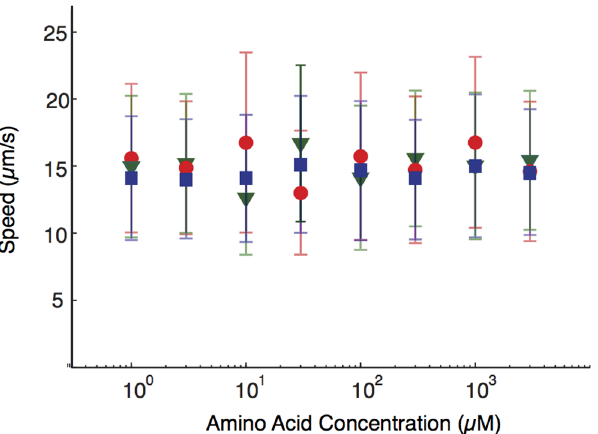
Fig 3. The E. coli running speed vs the chemoattractant concentrations. As in Fig 2, the three curves refer to serine (red), aspartate (blue) or aspartate with a background of 30 μ M of serine (green). The mean value is calculated by averaging over the population of bacteria and error bars represent the standard deviation of the velocity distribution over the population. in S1 Text. Fig 3 shows the dependence on concentration: the measured mean running speeds in aspartate and serine are 14.5 ± 5.0 μ m/s and 15.0 ± 6.0 μ m/s, respectively (mean and stan-